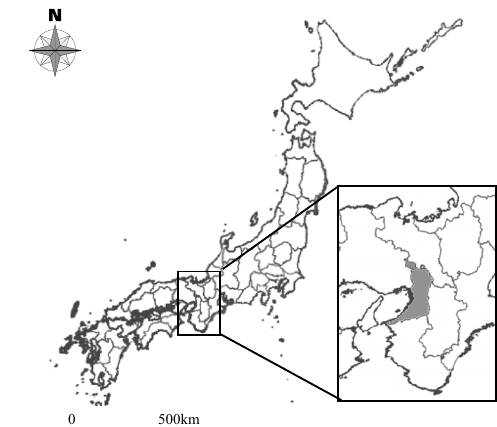
Figure 1 . Study area and its location. The grey area in the enlarged view of the map shows Osaka prefecture.